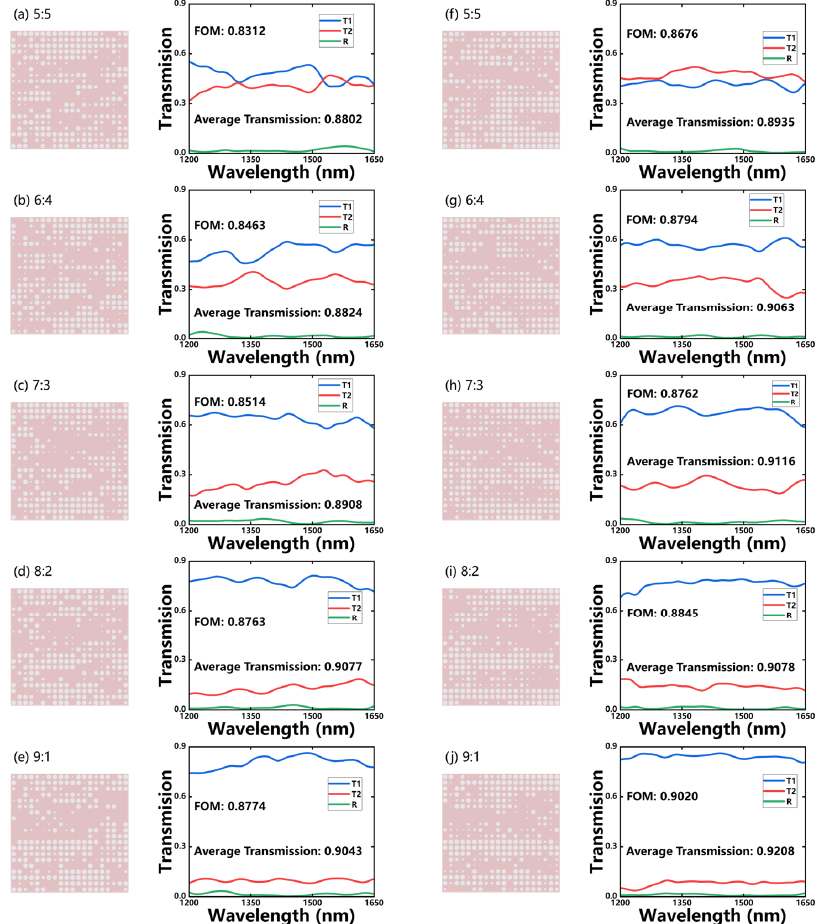
Figure 7. The MMI structures and their transmission spectra for the optimal devices generated by WGAN ( a – e ) or WGAN-sim ( f – j ), respectively, for five different power-splitting ratios.